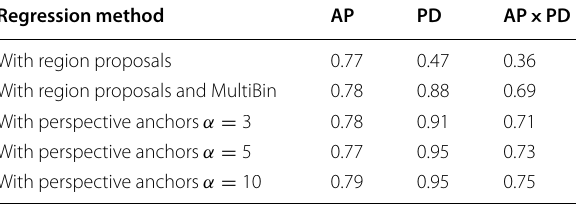
With perspective anchors α = 10 0.79 0.95